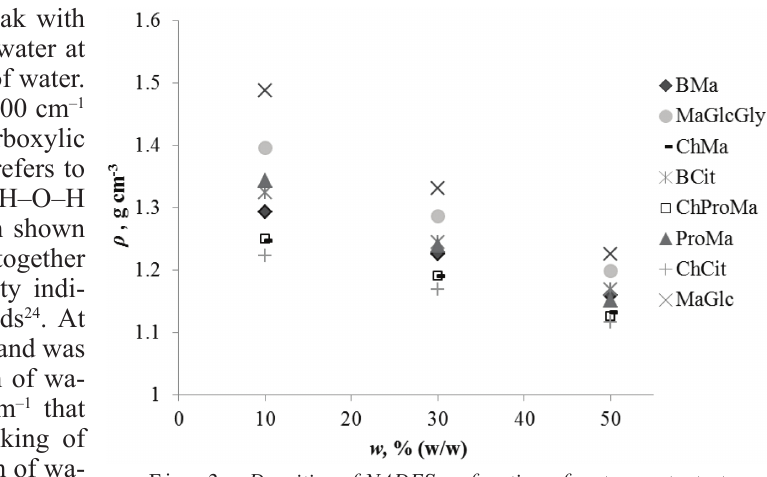
Fig. 3 – Densities of NADES as function of water content at 298